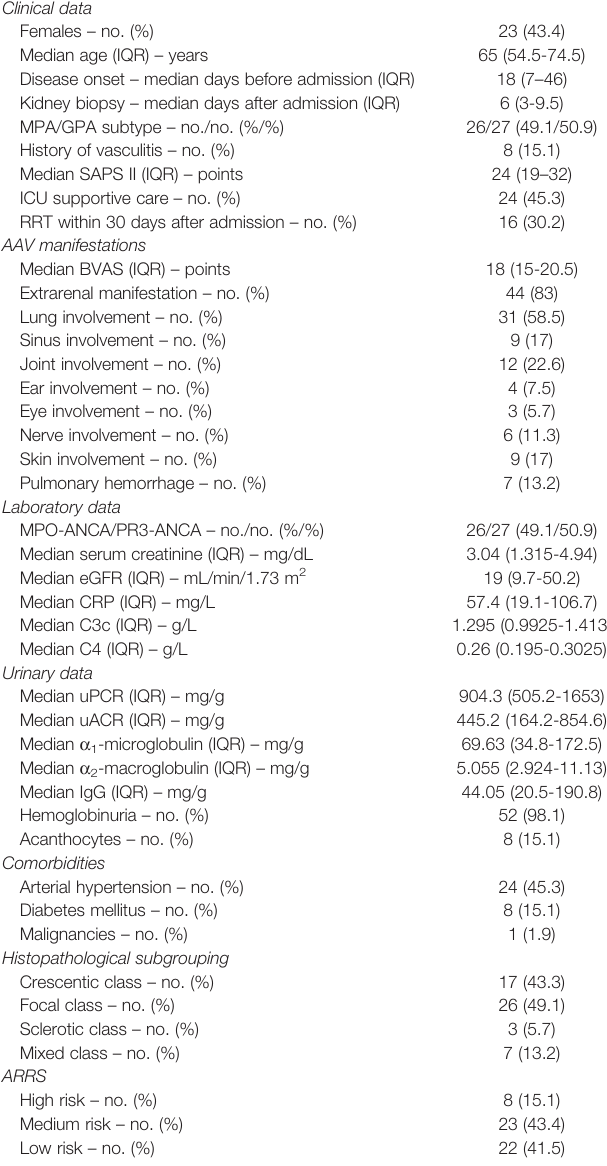
TABLE 1 | Clinical and laboratory parameters of the total ANCA GN